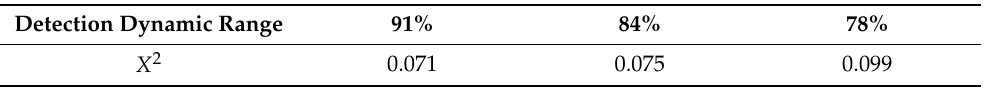
Table 2. Performance of the neural network model depends on the detection dynamic range, which is defined as the ratio of the number of meaningful pixels from a center to the total number of pixels across a half size of